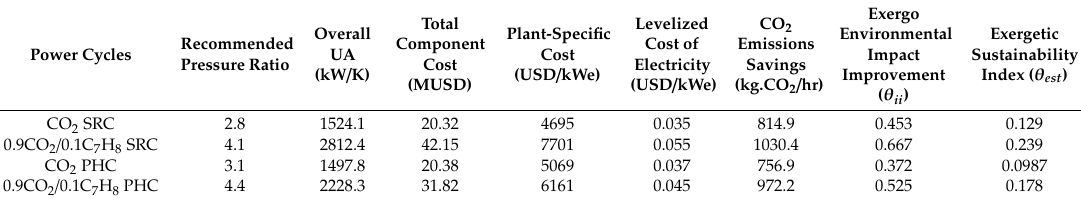
Table 7. Economic and Environmental performance indicators at recommended pressure ratios for all four bottoming power